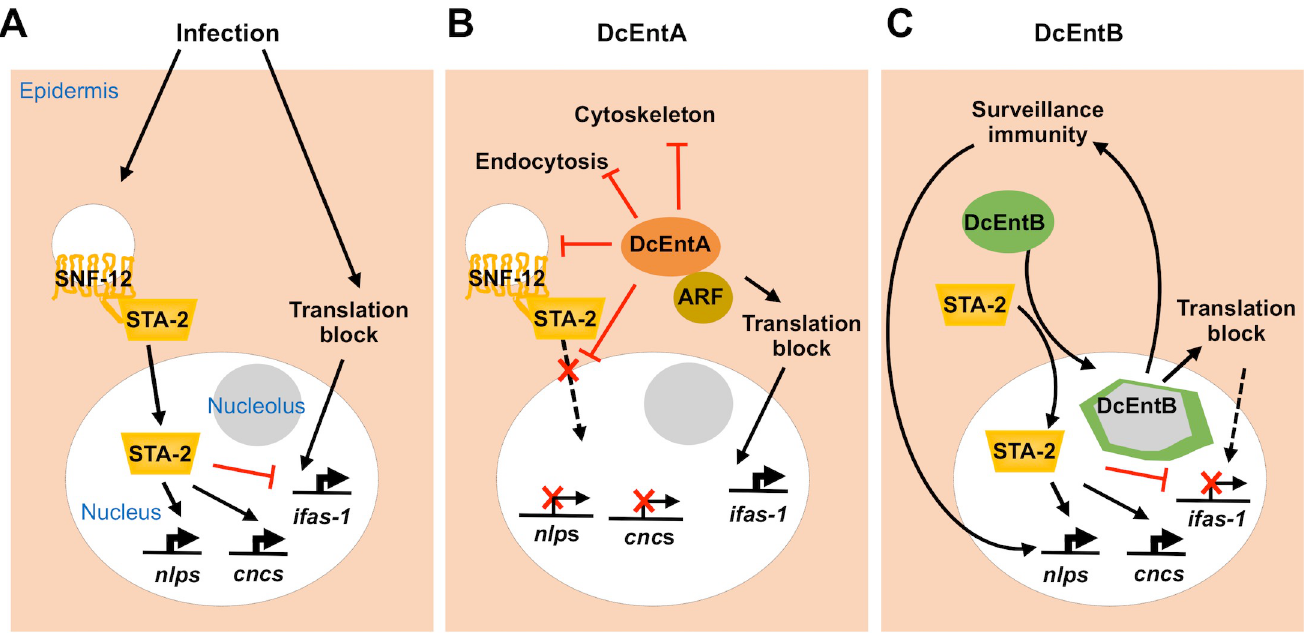
Fig 10. Models of the innate immune response to D . coniospora infection and the action of DcEntA and of DcEntB. ( A ) Infection by D . coniospora activates a pathway involving SNF-12 and STA-2. The translocation of STA-2 into the nucleus leads to an increase in the expression of nlp and cnc genes. An uncharacterized parallel pathway, potentially linked to surveillance of translation, activates ifas-1 , which is negatively regulated by STA-2. ( B ) DcEntA, via its interaction with host ARF GTPases and other protein partners (brown circle), through ADP ribosylation, potentially interferes with the normal innate immune response at multiple levels. It alters SNF-12 localization, blocks STA-2 nuclear translocation and AMP gene expression. It inhibits translation, leading to an increase in ifas-1 expression, accentuated by the loss of the repressive function of STA-2. DcEntA interferes with endocytosis, disrupts the cytoskeleton and causes increased cuticle fragility, potentially further increasing susceptibility to infection. ( C ) When DcEntB is expressed in hyp7, it localises to the nucleolus. Expression of DcEntB drives STA-2 into the nucleus, leading to an increase in nlp and cnc gene expression and suppressing ifas-1 expression. DcEntB alters the shape and size of the epidermal nucleoli. This provokes a surveillance mechanism leading to the expression of nlp but not cnc